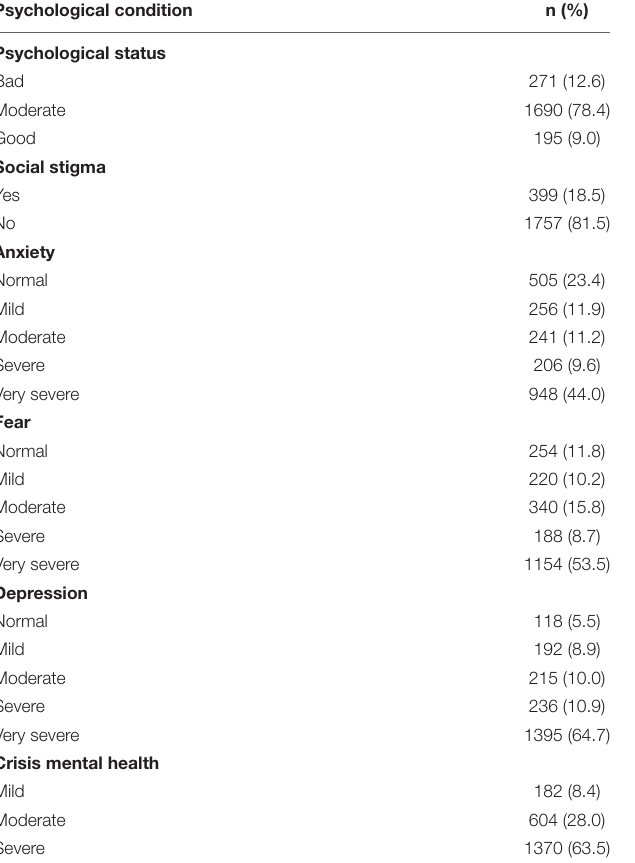
TABLE 2 | Psychological condition, stigma, and crisis mental health during pandemic